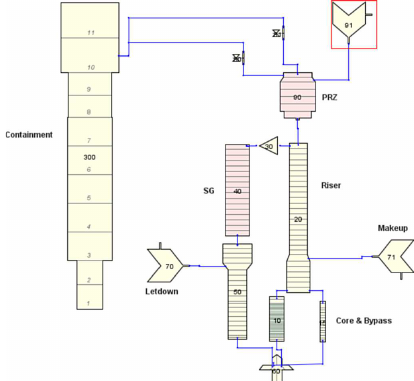
Fig. 8. SMART RPV one-dimensional model for TRACE developed by TRACTEBEL [34].